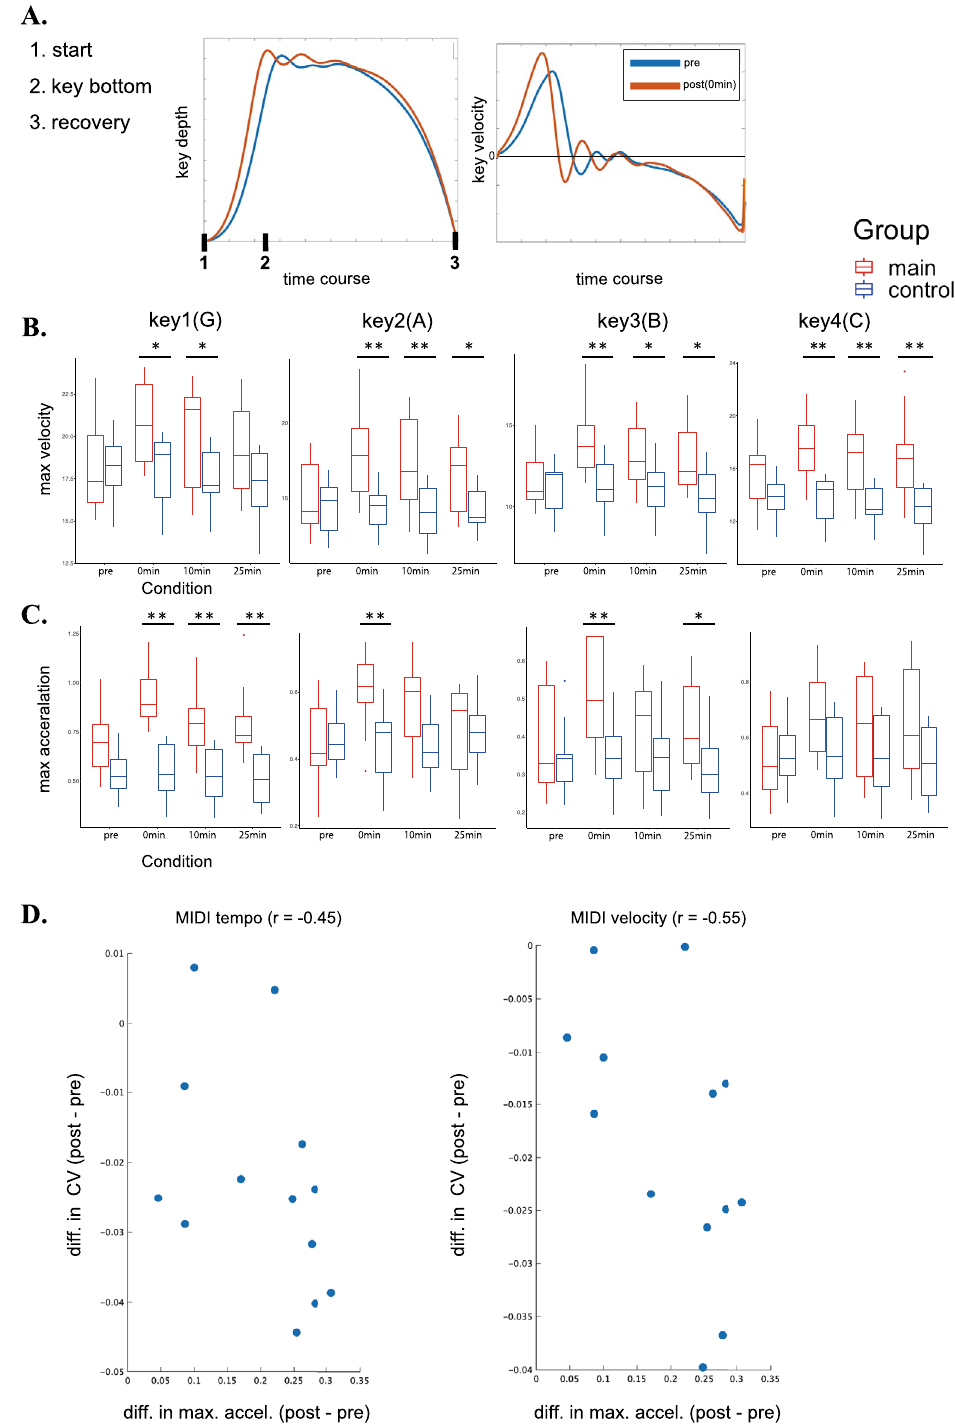
Figure 3. ( A ) Representative examples of the time-varying trajectories of the vertical position of the piano key (left) and their derivatives (right) at the pre-test (blue) and post-test (i.e. 0 min after the conditioning) (red) of one representative pianist in the main group. ( B ) and ( C ) Box plots of the group means of the maximum descending velocity ( B ) and acceleration ( C ) of the trajectories of the four keys to be struck (i.e. key1–4) before and after training (x-axis) in the main (red box) and control (blue box) groups. *p < 0.05, **p < 0.01. ( D ) Scatter plots of the differential values between the pre-test and post-test in the maximum keystroke acceleration relative to the CV of the keystroke timing (left panel) and velocity (right